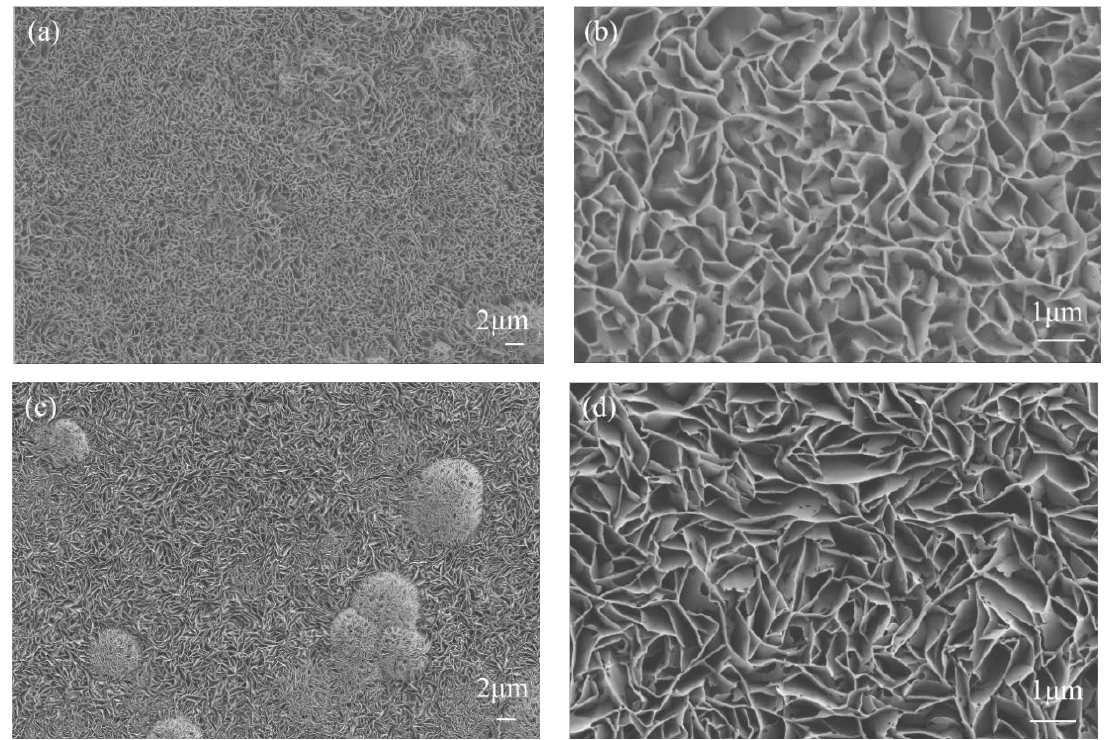
Figure 8. Surface scanning electron microscopy (SEM) images of typical samples: ( a ) CD: 2,000×; ( b )